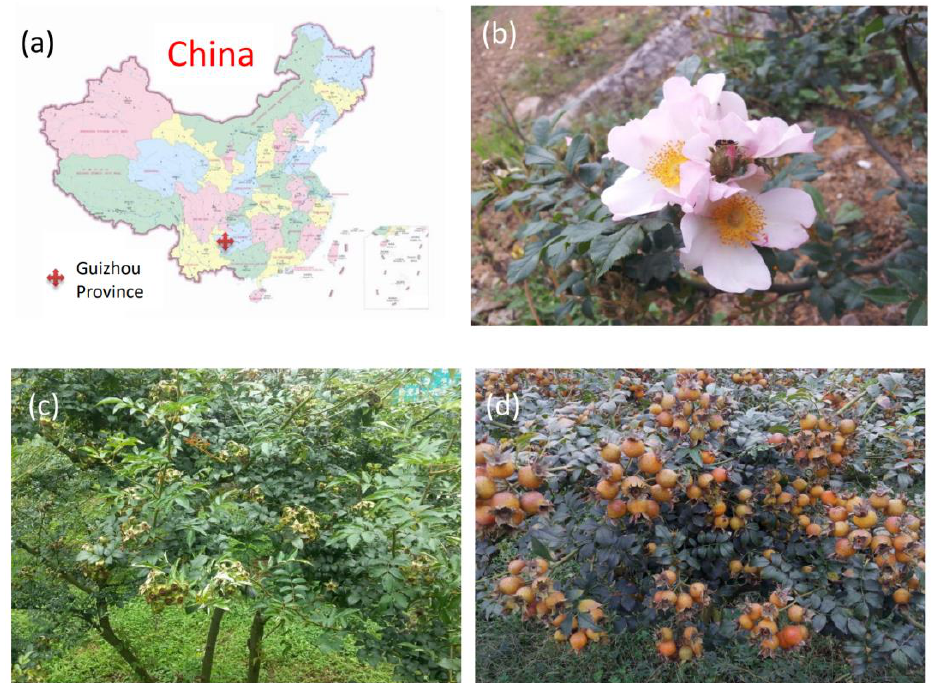
Figure 1. Origin and growth habit of Rosa sterilis . ( a ) the place of origin is Guizhou Province; ( b ) flowers (May); ( c ) green fruits (July); ( d ) mature fruits (October).